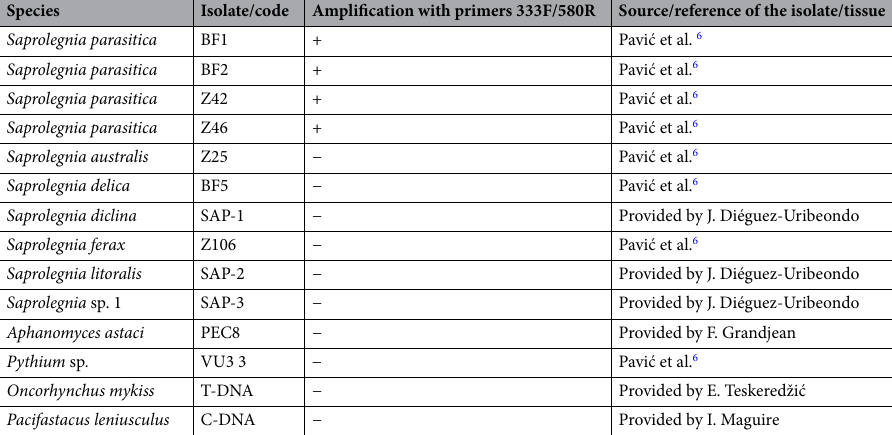
Species Isolate/code Amplification with primers 333F/580R Source/reference of the